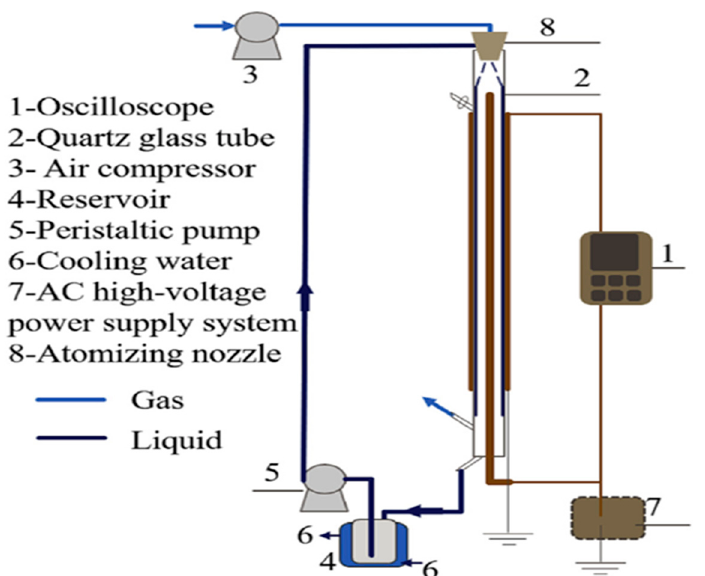
Figure 13. Spray dielectric barrier discharge (DBD) reactor set up used for the degradation of para- cetamol [50]. paracetamol